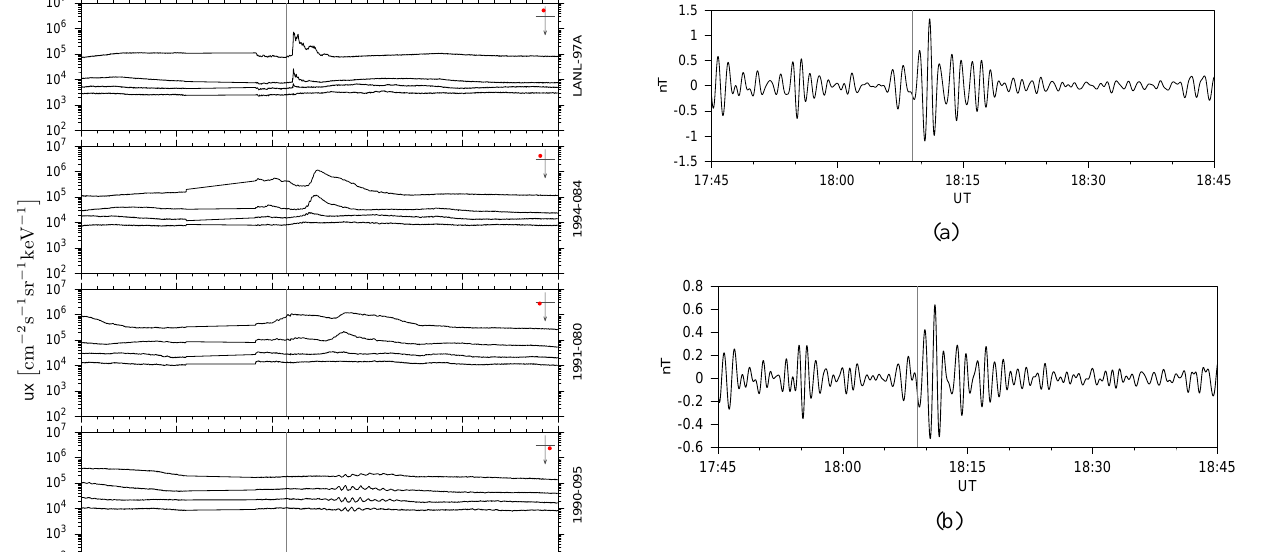
Fig. 2: Perturbations in the H component of the magnetic field at ground stations (a) Yinchuan [YCB] and (b) Kakioka [KAK]. The waveforms are bandpass filtered over the Pi2 frequency range.